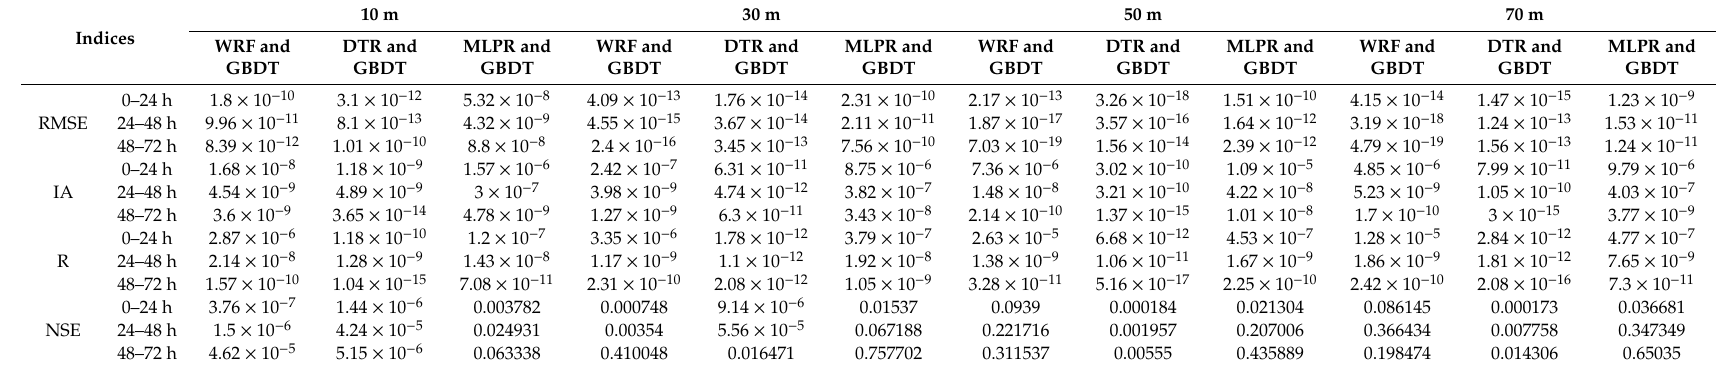
Table 11. p -value of each significant